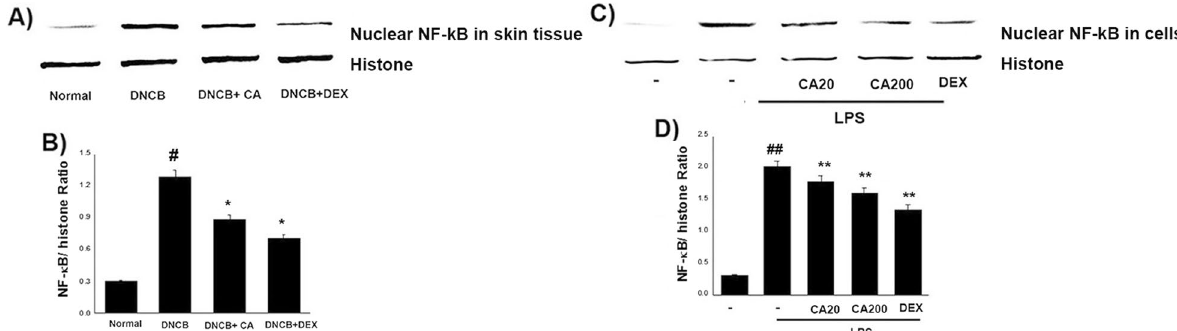
Fig. 6 Effect of CA on COX‑2 and iNOS expression in LPS‑stimulated peritoneal macrophages. Cells (5 concentrations of CA for 1 h and subsequently stimulated with LPS (200 ng/mL) for 24 h. A and C COX‑2 and iNOS expression was determined by western blotting analysis. B and D The relative COX‑2 and iNOS levels were determined by densitometry. Values are the mean determinations from three separate experiments ( # p < 0.05 vs. un‑stimulated cells, * p < 0.05 vs. LPS‑stimulated cells)